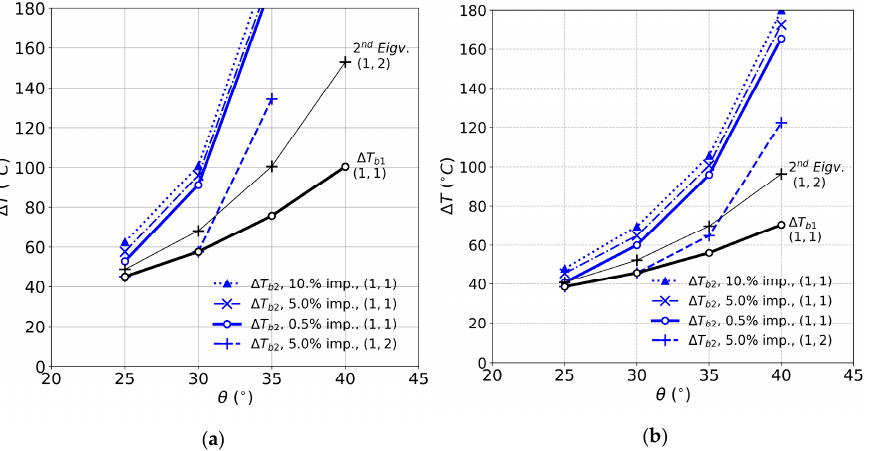
Figure 8. Mode jumping temperature for different laminates: ( a ) [𝜃/−𝜃] (cid:2870)(cid:3046) laminates; ( b ) [𝜃/−𝜃/𝜑/−𝜑] (cid:3046) laminates with 𝜑 = 𝜃 − 25